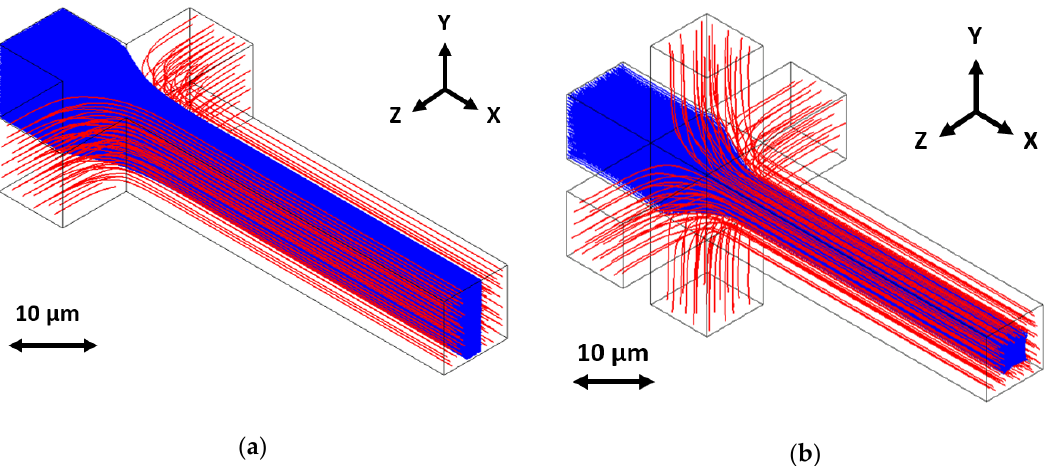
Figure 1. Hydrodynamic focusing occurs when sample fluid (drawn in solid blue) is squeezed and sheathed from ( a ) two dimensions (horizontal focusing) or ( b ) three dimensions (horizontal and vertical focusing) by a buffer fluid (drawn in striped red), controlling the position of sample fluid in the fluid channel.